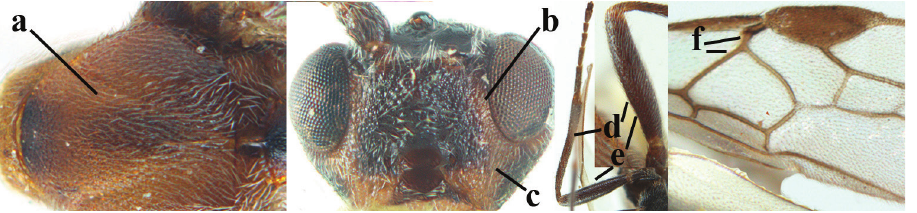
Mesoscutum (a), orbita (b) and malar space (c) largely yellowish brown; all femora and tibiae black or dark brown (d); fore and hind femora slender (e); vein 1-SR of fore wing angled with vein 1-M (f) ........... A. artesiariae sp. n.